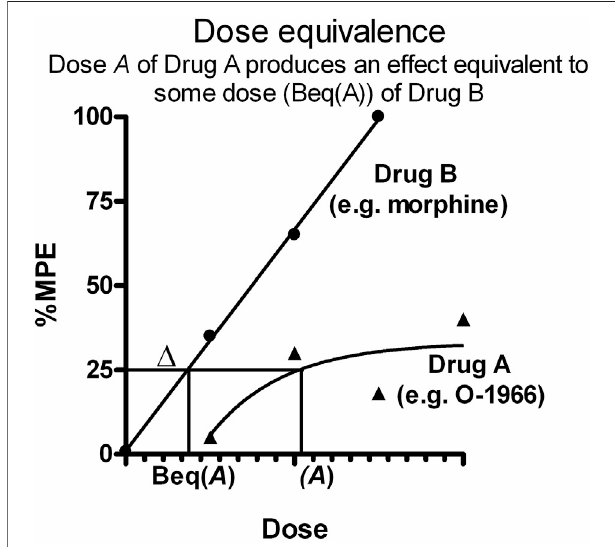
FIGURE 1 | Graphical representation of application of dose equivalence analysis to data from two drugs producing dose-response effects fi t to different slopes. Each dose A of Drug A (e.g. O-1966) is equally effective to somedoseofamoreef fi caciousdrug(DrugB,e.g.morphine).Thisequi- effective dose of Drug B is designated Beq (A) , or Δ . In the drug combination (A,B) , the administered Drug B dose B is increased by Δ , and the sum of the twodoses(B+ Δ )allowsthecalculationofexpectedeffects.Analysisproceeds comparing the expected effect with the observed